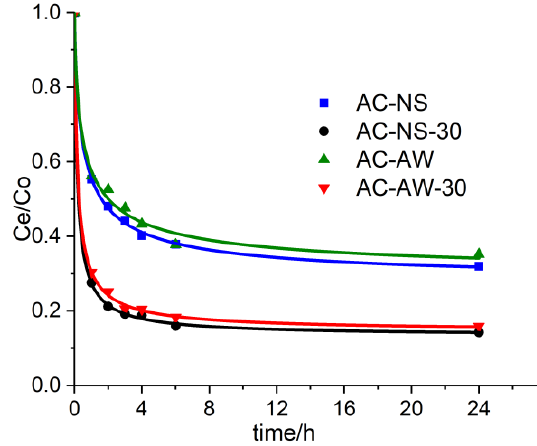
Figure 4. The experimental curves representing the adsorption kinetics of creatinine on the activated carbons: AC-NS (blue squares), AC-NS-30 (black circles), AC-AW (green triangles), AC-AW-30 (red triangles).